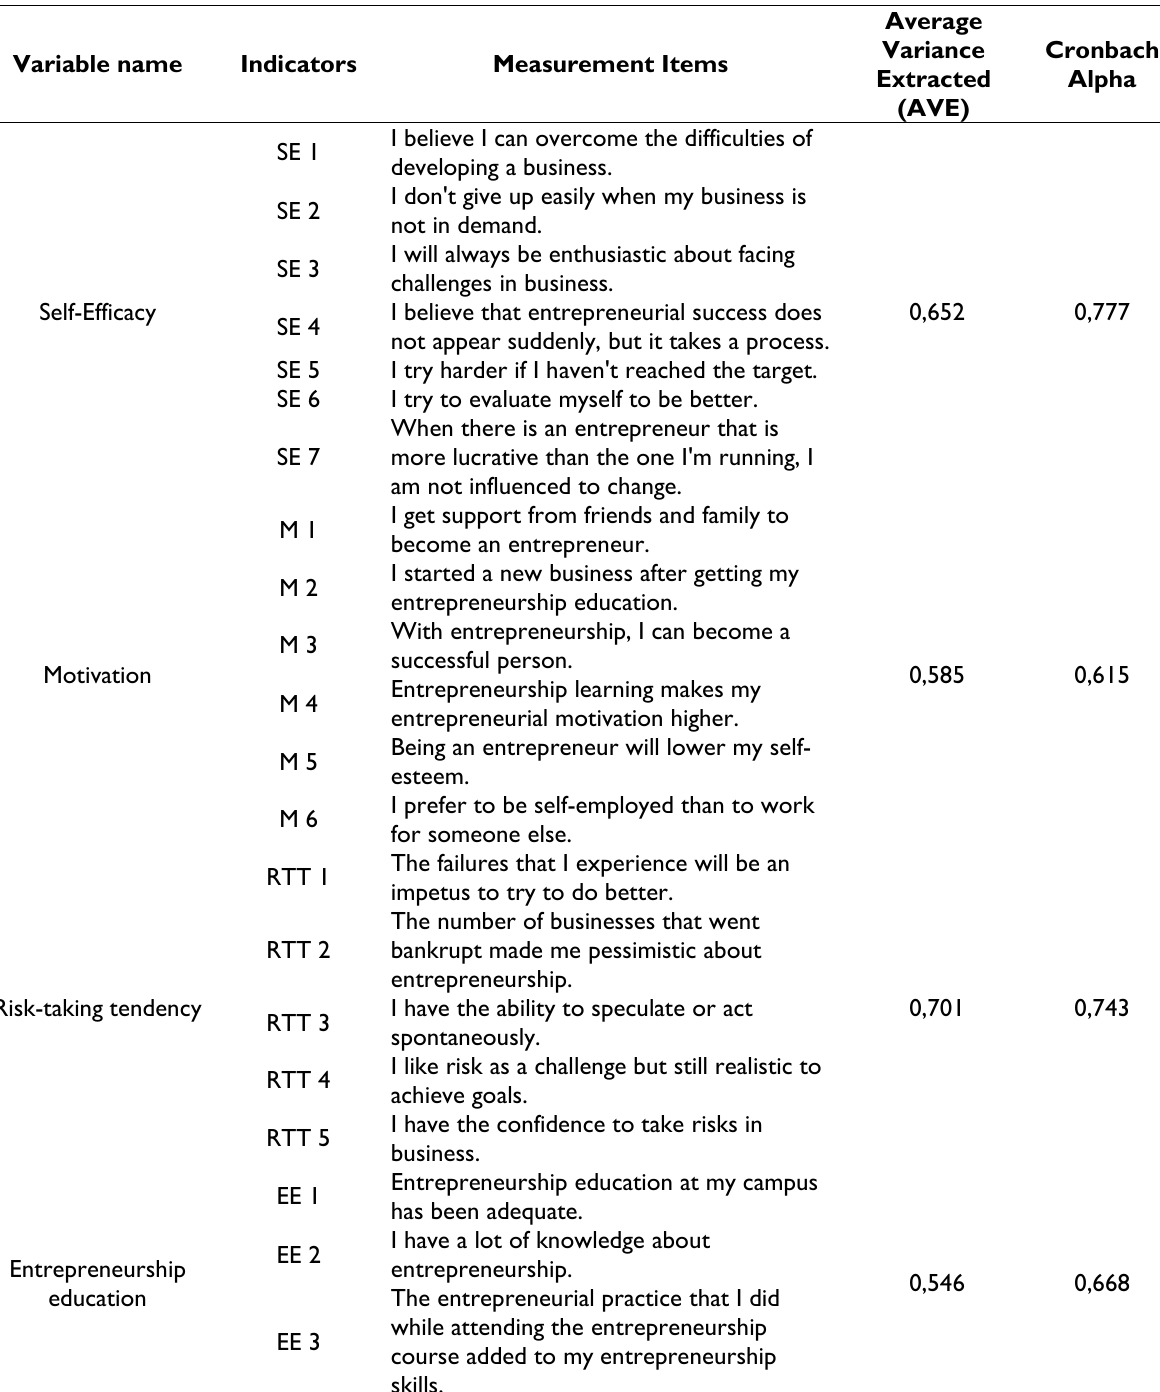
Table III. Operational Definition of